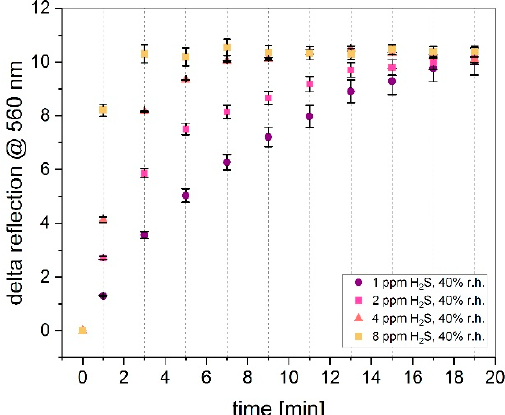
Figure 7. Delta reflection of the Cu-PAN layers printed on PE foil at a wavelength of 560 nm recorded over the measurement period. The samples were exposed to 1, 2, 4, and 8 ppm H 2 S for 20 min in synthetic air and a relative humidity of 40%.